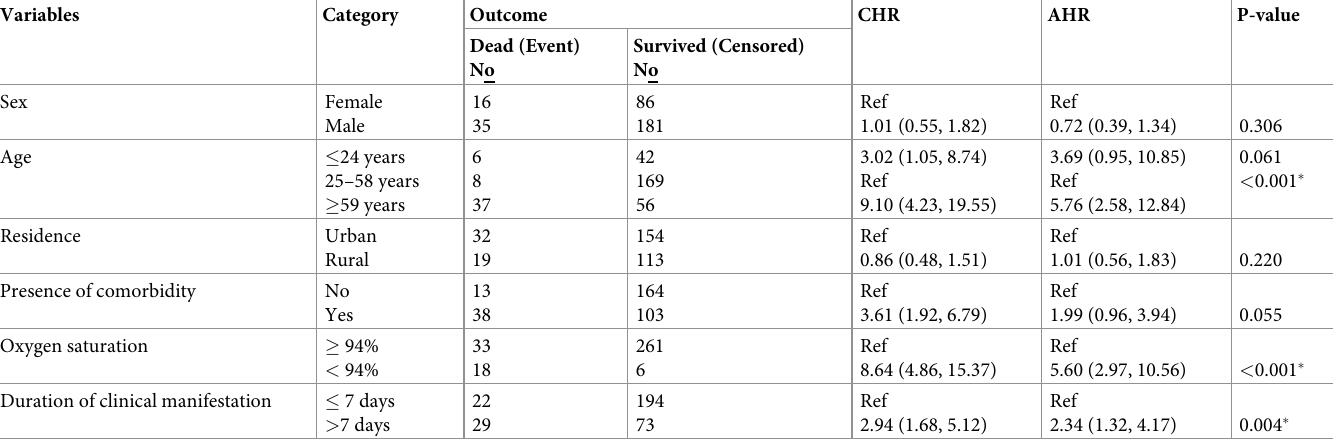
Table 5. Multivariable cox regression analysis of predictors of mortality rate among patients admitted with severe COVID-19 in WURH treatment center.